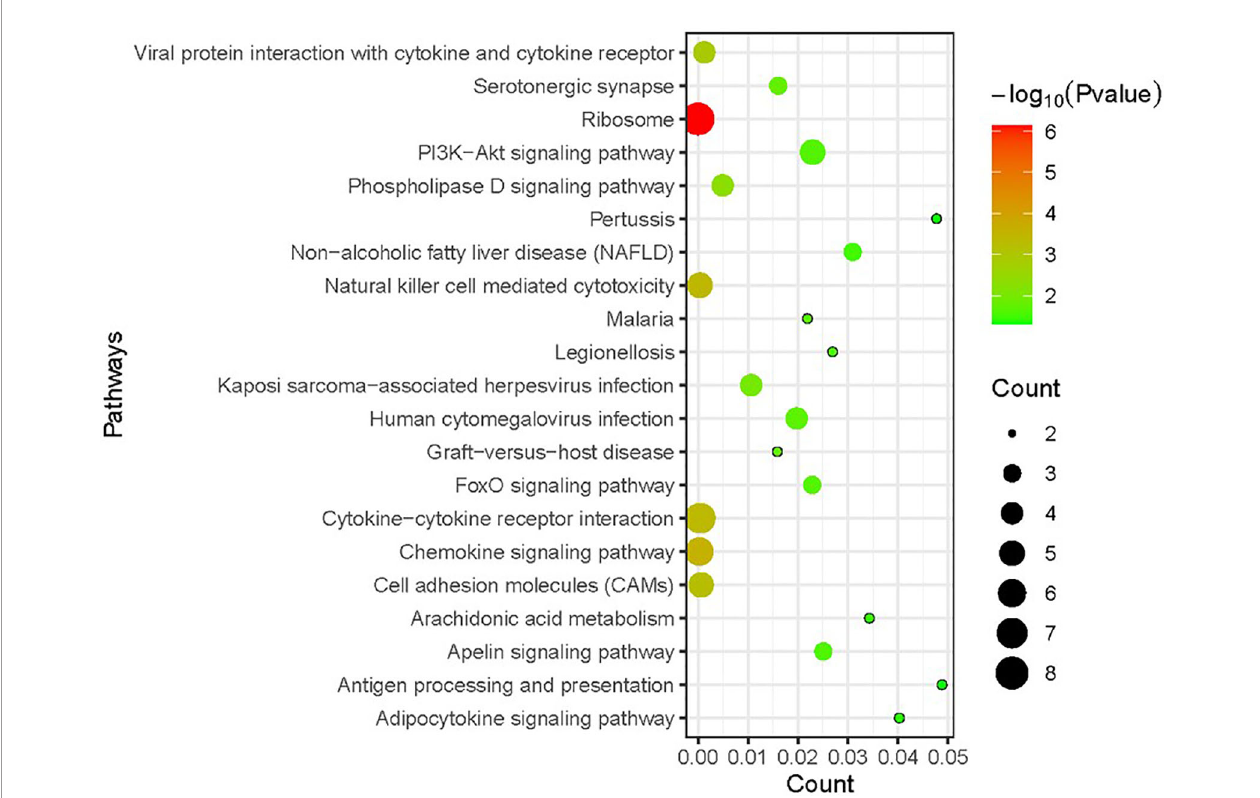
FIGURE 3 | Kyoto Encyclopedia of Genes and Genomes (KEGG) enrichment analysis of DEGs in RSV-infected children compared with healthy children. The size of the circle indicates the gene number; the colour represents the log P values. P value <0.05 and FDR < 0.01 were used as the thresholds for pathway assignment. Note that most DEGs were enriched in immune-related pathways such as “ chemokine signaling pathway ” , “ natural killer cell-mediated cytotoxicity ” and “ cytokine – cytokine receptor interaction ”